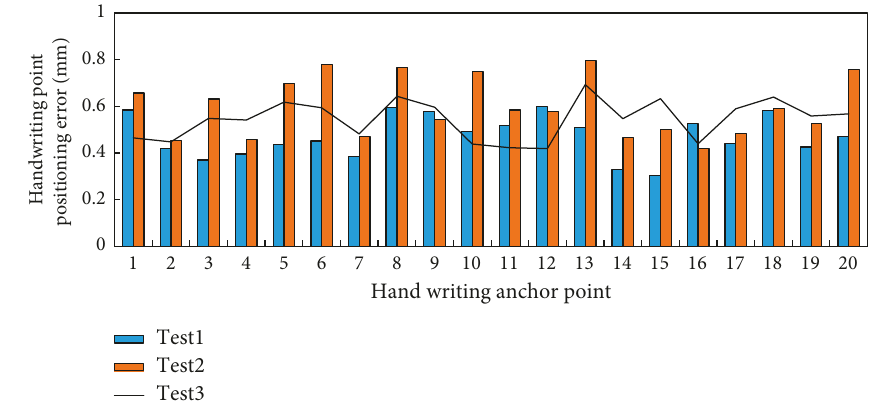
Figure 5: Results of three groups of studies.